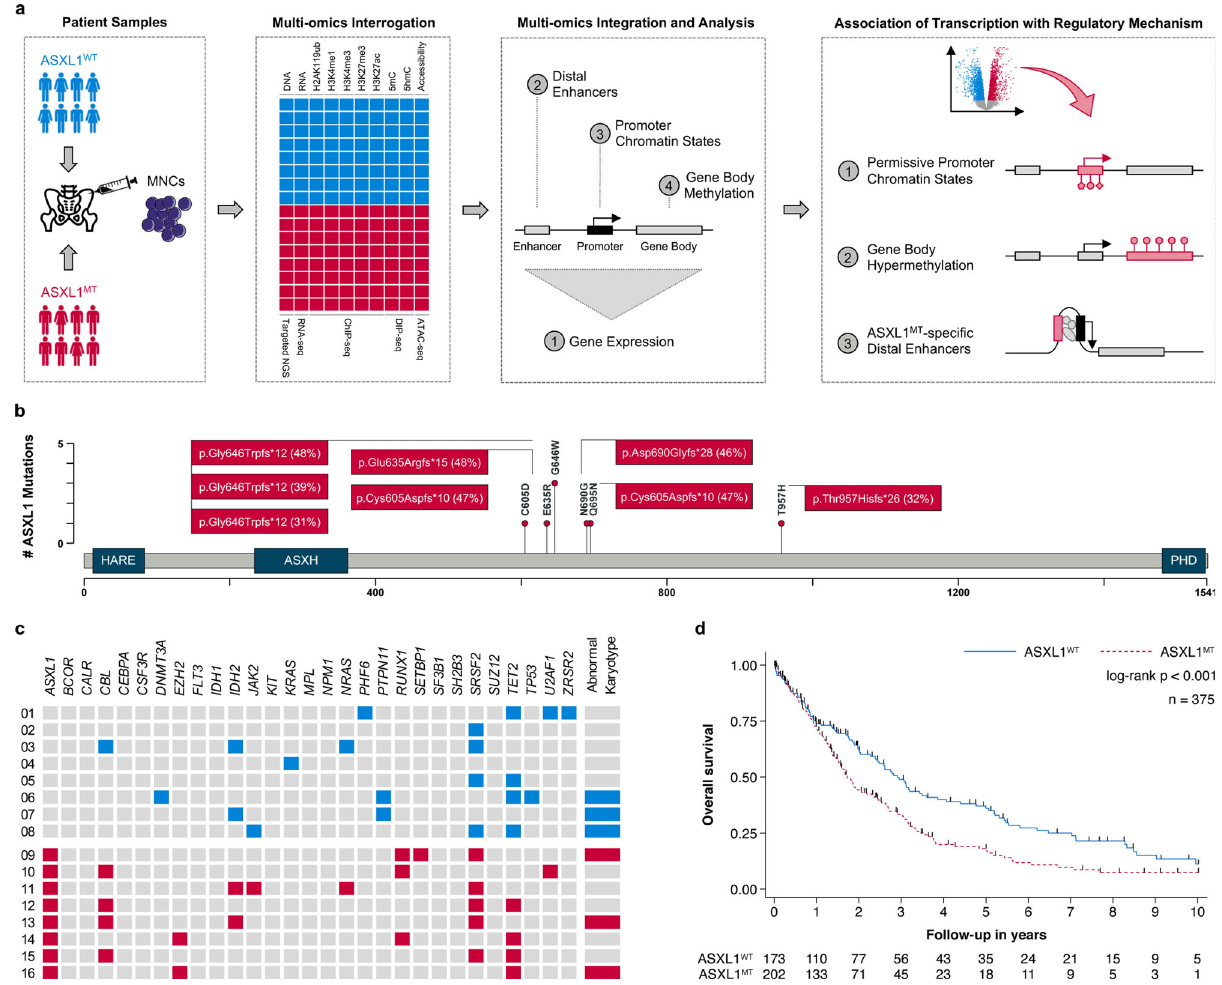
Fig. 1 Truncating ASXL1 mutations are of prognostic signi fi cance in chronic myelomonocytic leukemia and frequently co-occur with other mutations. a Flowchart showing the study design: An integrated multi-omics approach to discover ASXL1 MT -speci fi c epigenetic regulatory mechanisms associated with transcriptional up-regulation. b Lollipop plot showing that all mutations in ASXL1 resulted in a frameshift preserving the HB1, ASXL, restriction endonuclease helix-turn-helix (HARE) and LXXLL motif alpha helical (ASXH) domain but not the plant homeodomain (PHD). All observed variant allele frequencies were compatible with heterozygosity. c Heatmap showing the spectrum of co-mutations, which included spliceosome components, chromatin regulators, modulators of DNA methylation, and cell signaling molecules. The prevalence of abnormal karyotypes and the burden of co-mutations were similar between ASXL1 MT and ASXL1 WT patients. d Kaplan – Meier plot showing overall survival estimates for the 375 patients with chronic myelomonocytic leukemia from which the 16 patients in this study were sampled from (median follow-up 18 months). The presence of truncating ASXL1 mutations was associated with increased all-cause mortality in this patient population (median overall survival 1.72 years, 95% CI 1.51 – 2.19, n = 202 versus 2.92 years, 95% CI 2.39 – 3.61, n = 173; HR 1.54, 95% CI 1.19 – 1.98, p = 0.001). This association remained consistent after adjusting for age at diagnosis, sex, and the other factors of the Mayo Molecular Risk Strati fi cation Model (HR 1.37, 95% CI 1.05 – 1.78, p = 0.019, n = 375) 8 . There were no violations of the proportional hazards assumption ( p = 0.113). Source data are provided as a Source Data fi